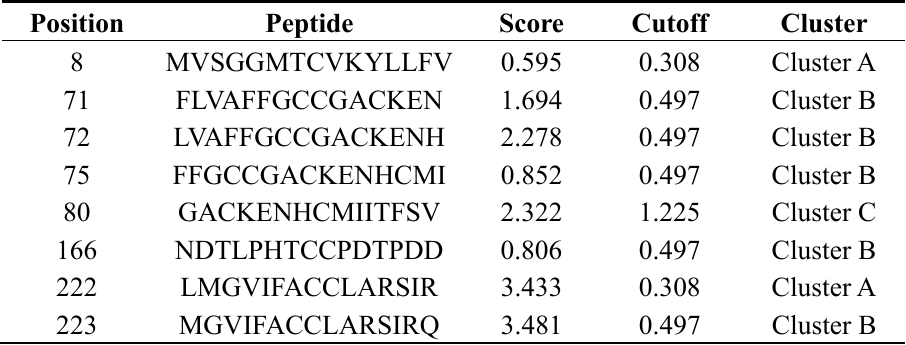
Table 1. Predicted palmitoylation sites (CSS-Palm 3.0 software suite) in CD63 homologue of T. molitor